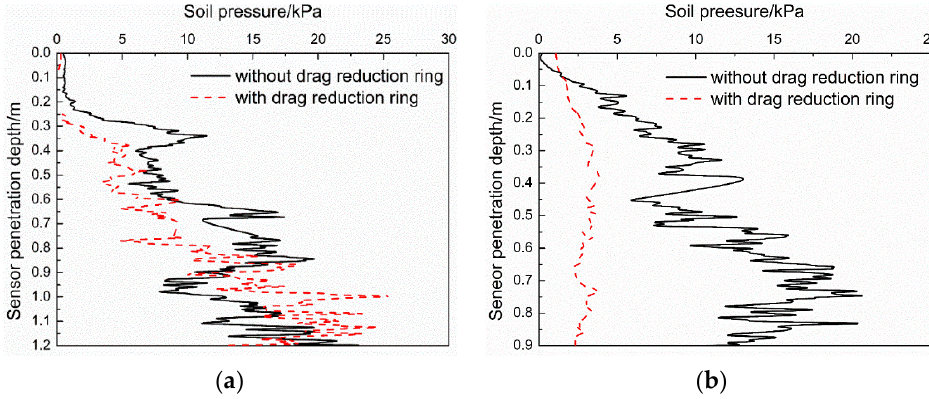
Figure 16. Lateral soil pressure, without and with an anti-drag ring: ( a ) Lower side of the anti-drag ring; ( b ) Upper side of the anti-drag ring.